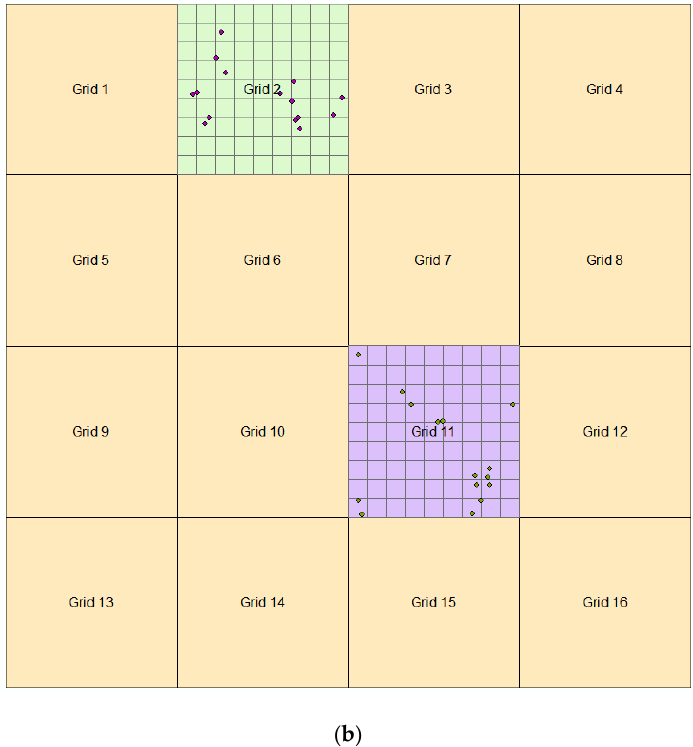
Figure 1. Study area and the layout of TxSON. ( a ) Location of the study area and soil moisture stations; ( b ) the station and the grid layout of TxSON. The TxSON soil moisture has 16 grids, ranging from grid 1 to 16, each 9 km by 9 km in size. Grids 2 and 11 are divided into 1 km subgrids. The dimension of the TxSON is 36 km by 36 km. The figure only shows the stations within grids 2 and 11; stations included in other grids were omitted for this study.